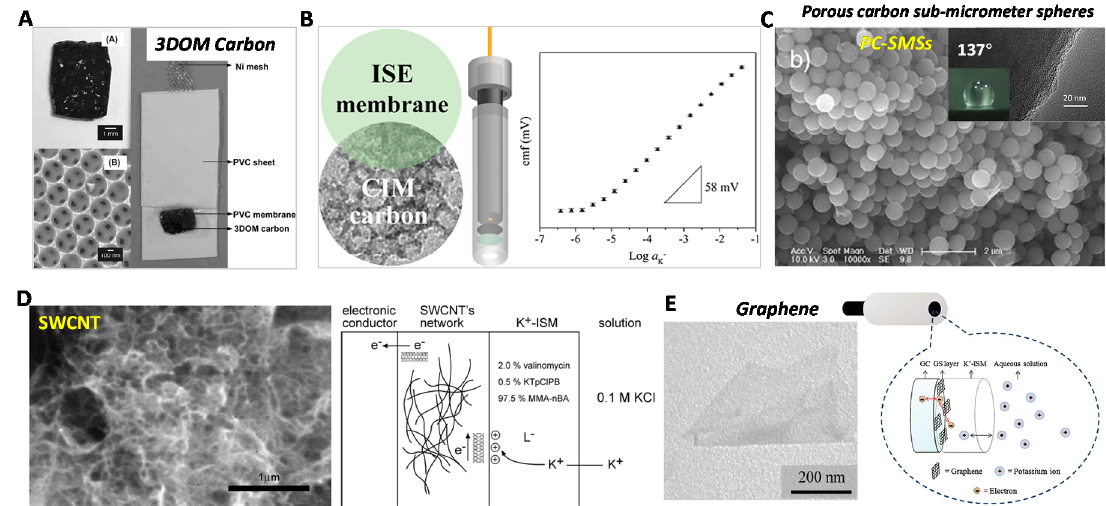
Figure 5. Carbon-based SC-ISEs. ( A ) High-surface 3D-ordered microporous (3DOM) carbon as a SC transducer for SC-ISEs. Reprinted with permission from [50], Copyright (2007) American Chemical Society. ( B ) Colloid-imprinted mesoporous (CIM) carbon with higher surface area as a SC transducer for SC-ISEs. Reprinted with permission from [52], Copyright (2014) American Chemical Society. ( C ) The porous carbon sub-micrometer spheres (PC-SMSs) for superhydrophobic SC transducer with the contact angle up to 137°. Reprinted with permission from [53], Copyright (2015) Elsevier. ( D ) Single- wall carbon nanotube (SWCNT)-based SC-ISEs and the illustrated EDL capacitance response mechanism. Reprinted with permission from [54], Copyright (2008) American Chemical Society. ( E ) with permission from [55], Copyright (2012) Royal Society of Chemistry.